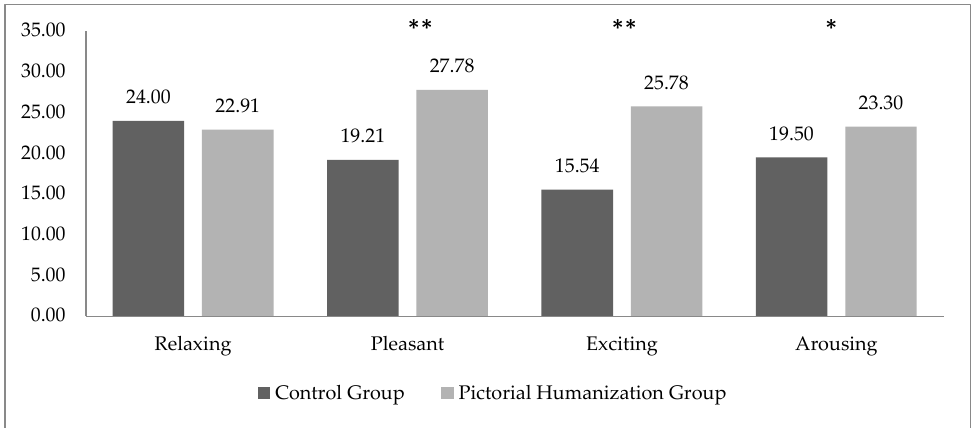
Figure 1. Mean scores for positive QAL scales in CG and PHG parents. * p < 0.05; ** p < 0.005.